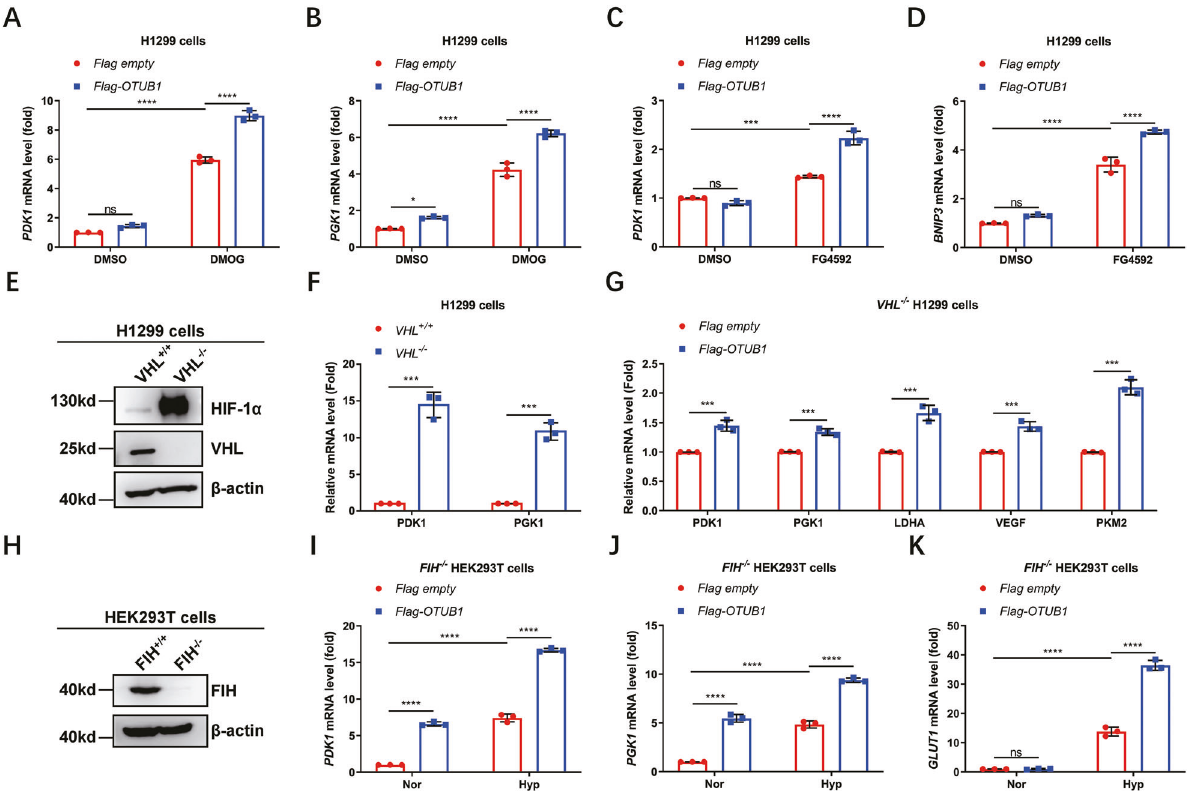
Fig. 3 OTUB1 augments hypoxia signaling pathway independent of HIF-1 α hydroxylation. A , B qPCR analysis of PDK1 ( A ) and PGK1 ( B ) mRNA in H1299 cells transfected with or without Flag-OTUB1 and cultured under normoxia (21% O 2 ) for 24 h, followed by treatment with DMSO or DMOG (1 mM) for 8 h. Flag empty vector was used as a control. Two-way ANOVA analysis; Data show mean ± SD; Tukey ’ s multiple comparisons test; ns, not signi fi cant, *Adjusted p < 0.05, **Adjusted p < 0.01, ***Adjusted p < 0.001, ****Adjusted p < 0.0001; Data from